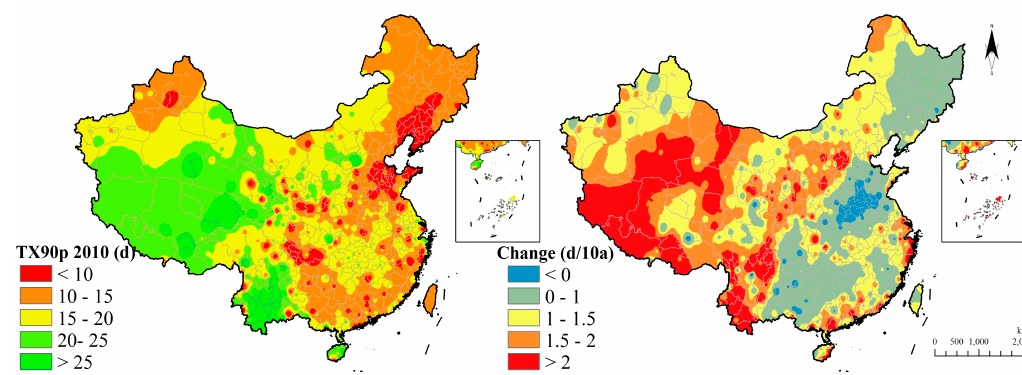
Figure 11. Warm day indicator distribution and change.